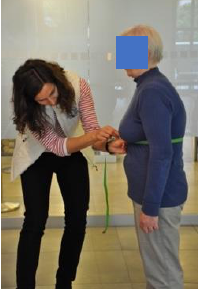
Figure 3. Circumferential chest expansion measurement.